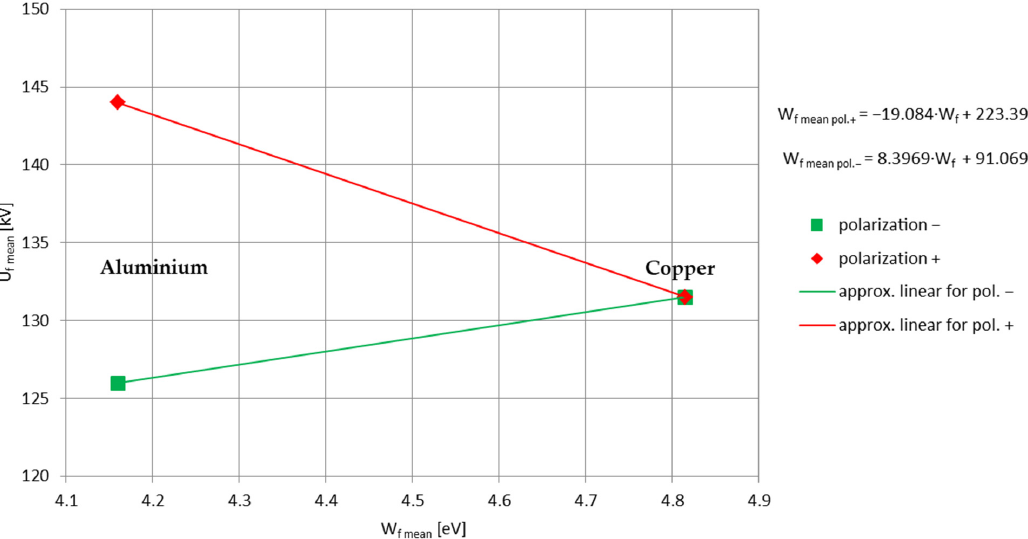
Figure 15 . The enlarged images of the upper parts of the antennas subjected to bidirectional dis- charges: ( a ) copper and ( b ) aluminum (both 8 s exposure). Image ( b ) is more enlarged than ( a ). Different corona patterns can be noticed.